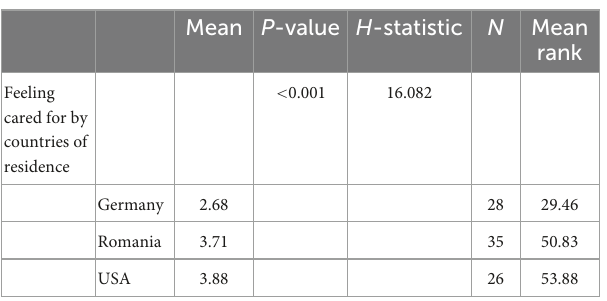
TABLE 9 The results of Spearman’s correlation for the Romanian group.